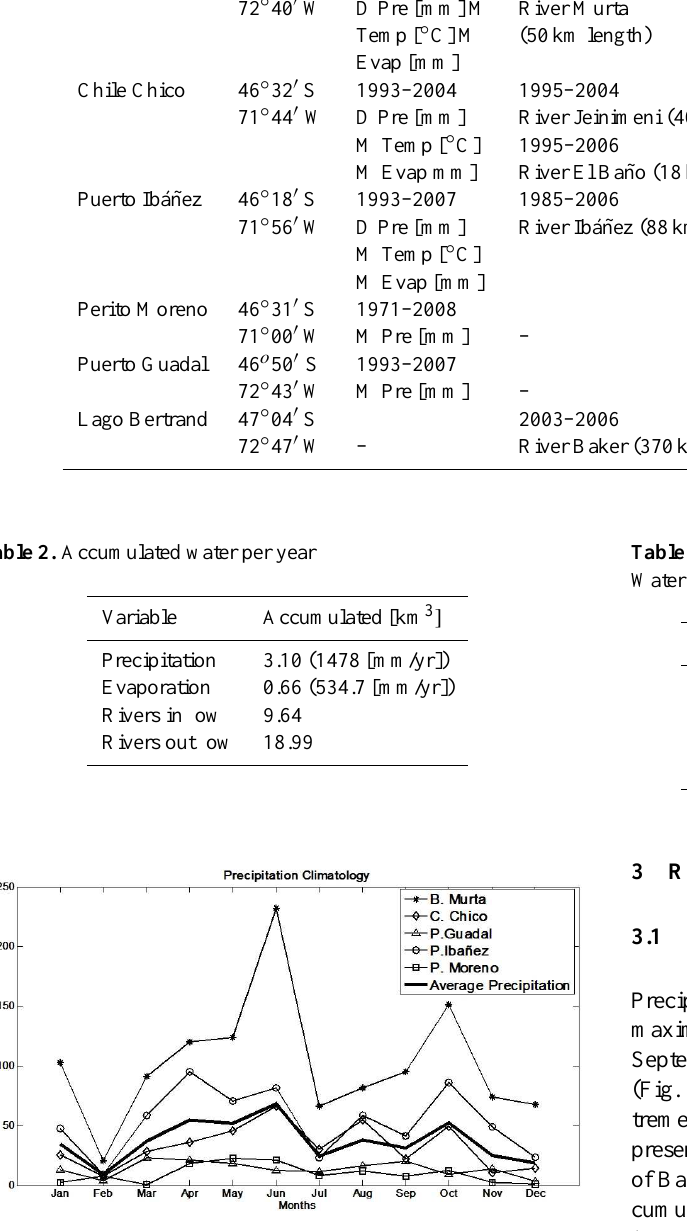
Table 1. Meteorological and river discharge monitoring stations. D and M refers to daily and monthly mean values, respectively, and dates refer to the range of data availability. All river discharge stations are inputs to the system, except for River Baker which is the sole output Stations